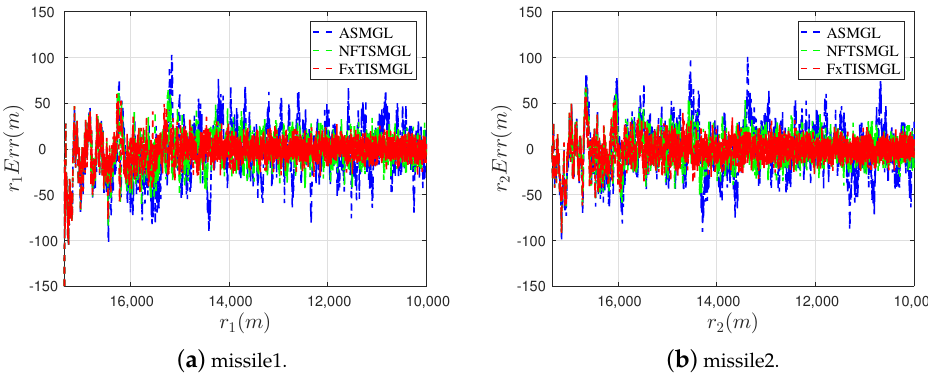
Figure 9. The estimation errors of the missile-target